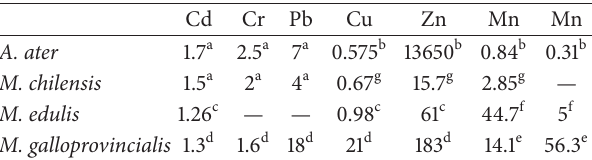
Table 1: Comparison of heavy metal mean content in whole A. ater with related